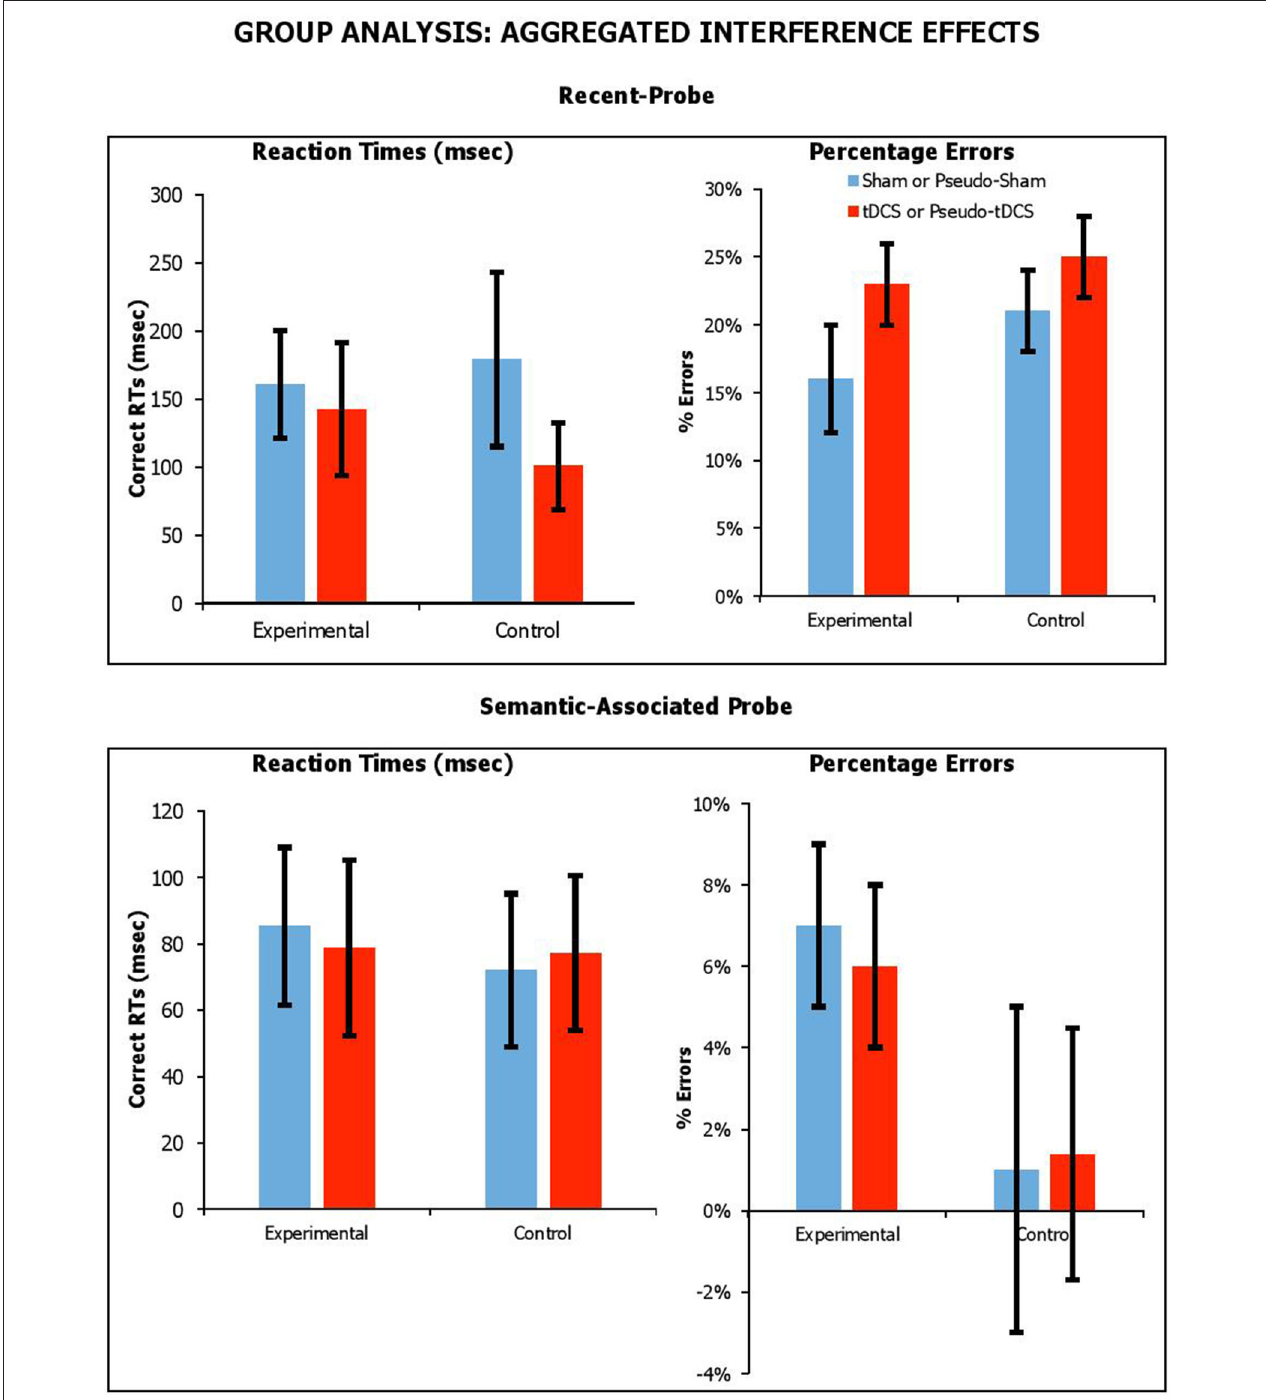
FIGURE 5 | Aggregated interference across probe tasks (recent-probe, upper panel; semantic-associated probe, lower panel) stimulation conditions and participant groups. Interference measured as difference between negative probes and the average of recent-negative and non-recent-probes or as difference between negative unrelated probes with the average of negative-associated and -combined. Error Bars indicate Standard Error.